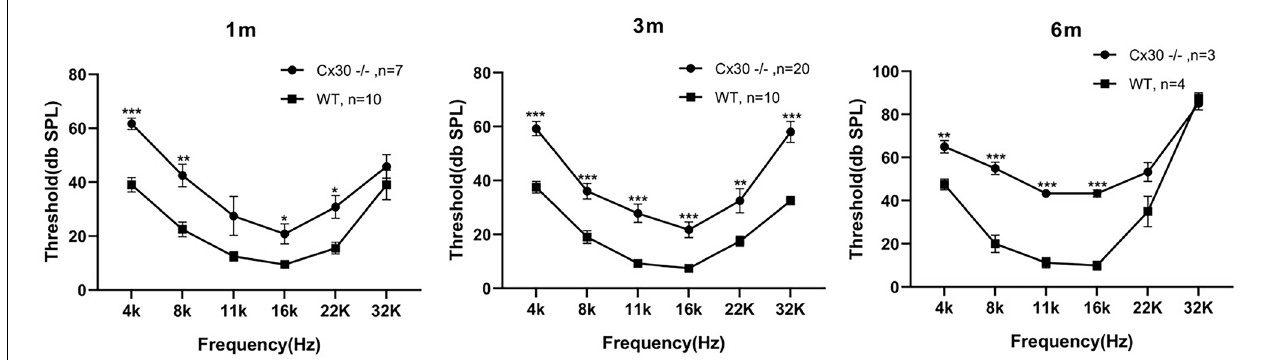
FIGURE 2 | Mild hearing loss in Cx30 -/- mice. ABR waveforms were recorded from Cx30 -/- and WT littermate mice at 1 m, 3 m, 6 m. 1 m: 1-month-old; 3 m: 3-month-old; 6 m: 6-month-old. Data presented as Mean ± SEM; n > 3 in each group. t -test. * p < 0.05, ** p < 0.01, *** p < 0.001. ABR, Auditory brainstem